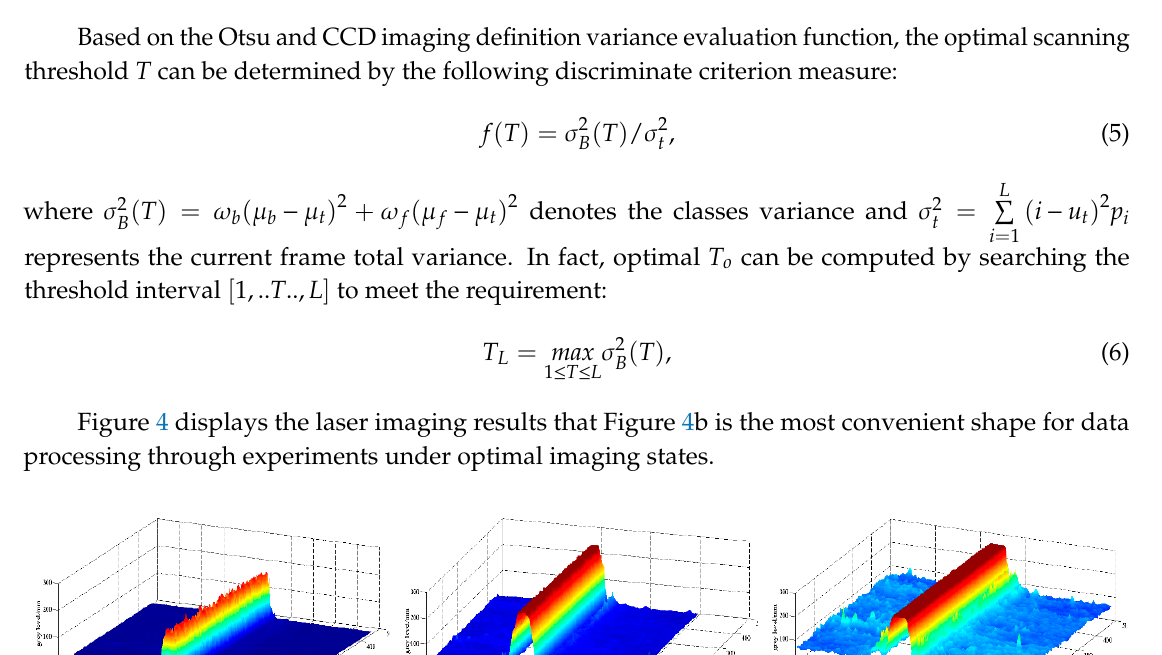
(b) Figure 5. The schematic illustration of the binocular CCD laser image scanning system. ( a ) The schematic working principle diagram; ( b ) The corresponding devised experimental system. In the system, the 3D images pixels (12 ‐ bit) are indirectly mapped from the calibrated laser triangulation strategies (the metric is millimeter). Therefore, the image ROI was reconstructed by converting the 3D distance point cloud of the object surface. From the experiments in Figure 6, we can visually observe that the system can change its detection accuracy and sensitivity for depth information by finely adjusting θ according to the detection requirements. Generally, CNN ‐ DL model training requires a large number of labeled examples. We utilized the angular fine adjustment to acquire different scanning images for the testing samples as an auxiliary data augmentation method. The depth of variation was explicitly added to the training samples. Based on this method,